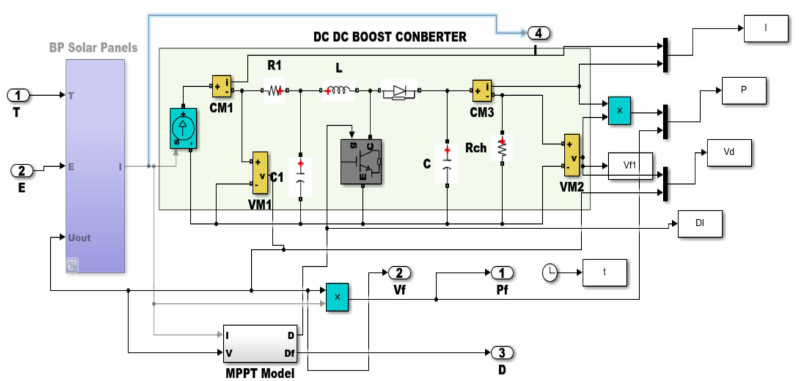
Figure 11. Solar panel with MPPT Controller.